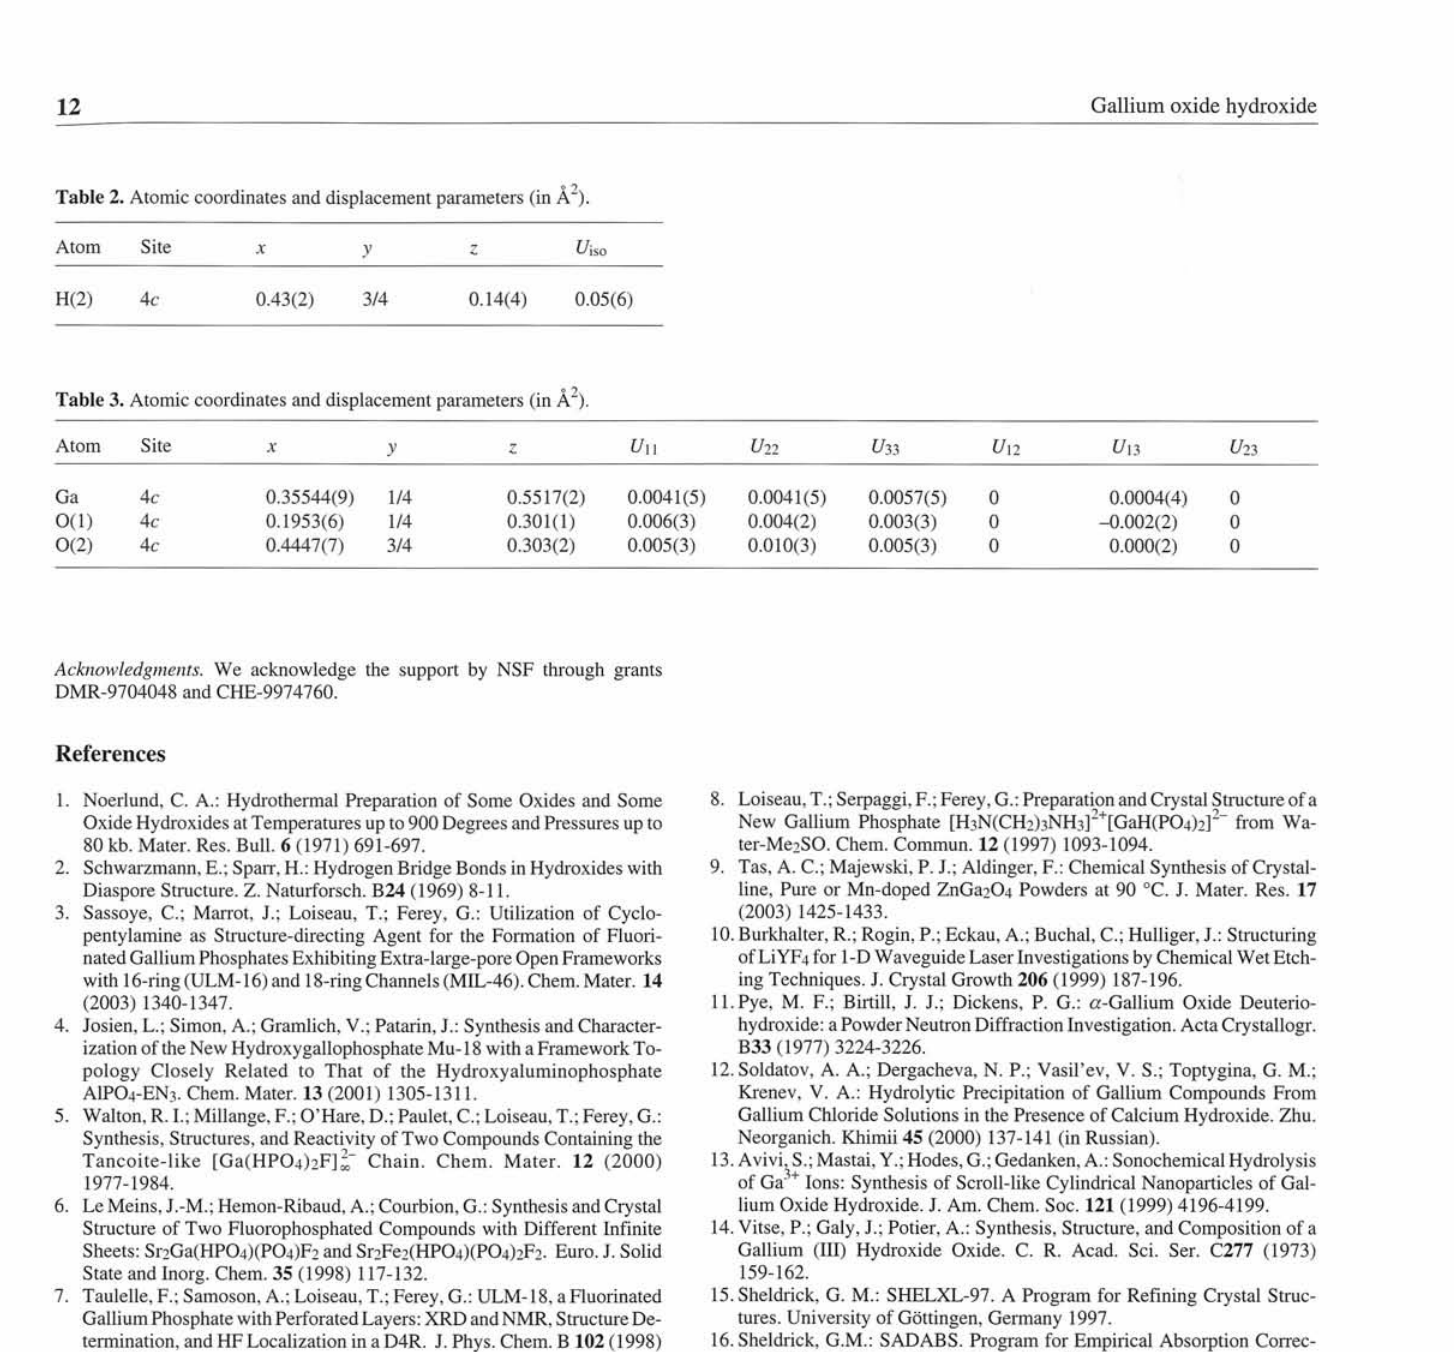
Table 2. Atomic coordinates and displacement parameters (in À 2 ).